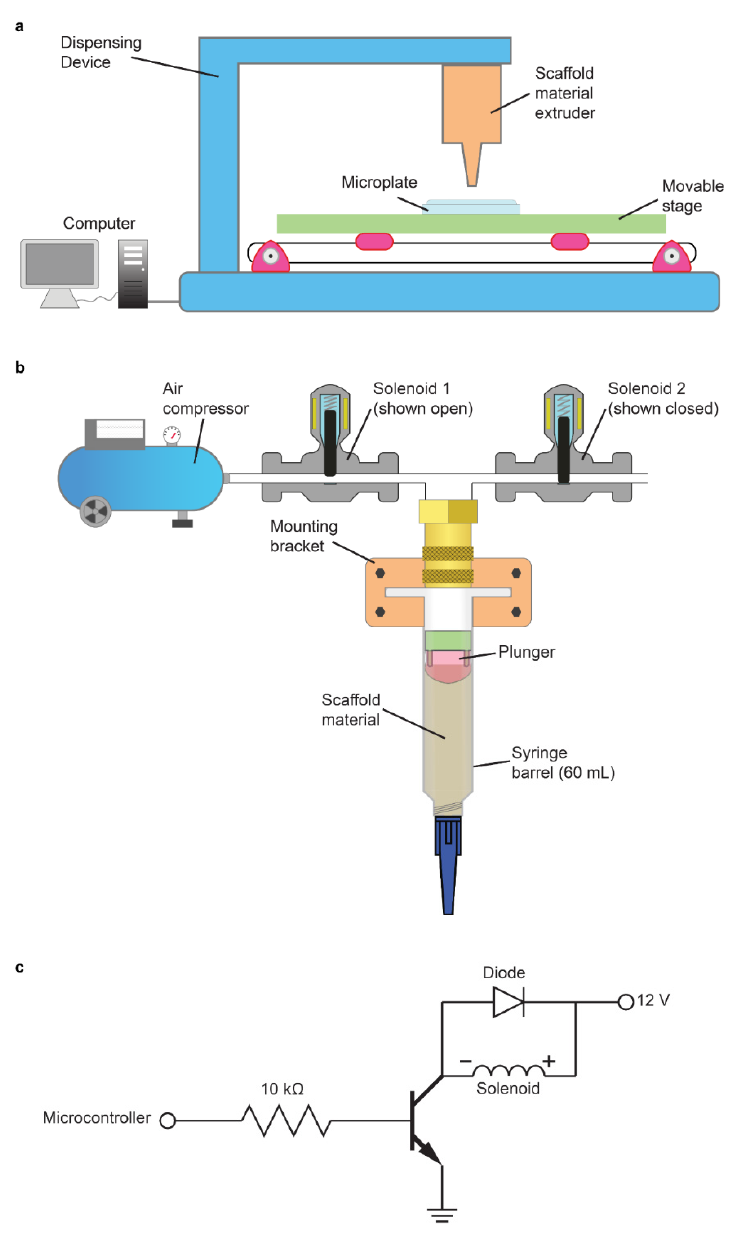
Figure 1. Automated scaffold dispenser design and illustration. ( a ) Automated scaffold dispensing apparatus based on a stepper-motor powered movable stage and a custom extruder capable of distributing high-viscosity materials. ( b ) Pneumatic extruder design detail. An external source of pressurized gas is used to depress the plunger of a syringe filled with scaffold solution; management of the applied pressure is achieved with a pressure regulator and two computer-controlled solenoid valves. ( c ) Solenoid valve control circuit.